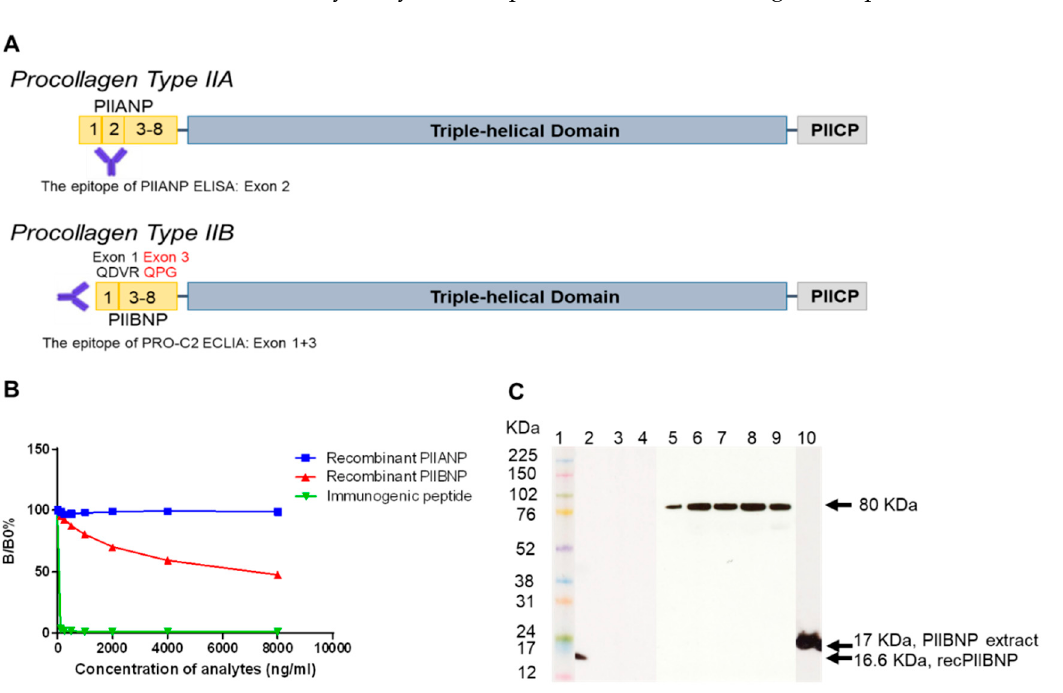
Figure 1. ( A ) Schematic illustration of type IIA collagen NH 2 -propeptide (PIIANP) and type